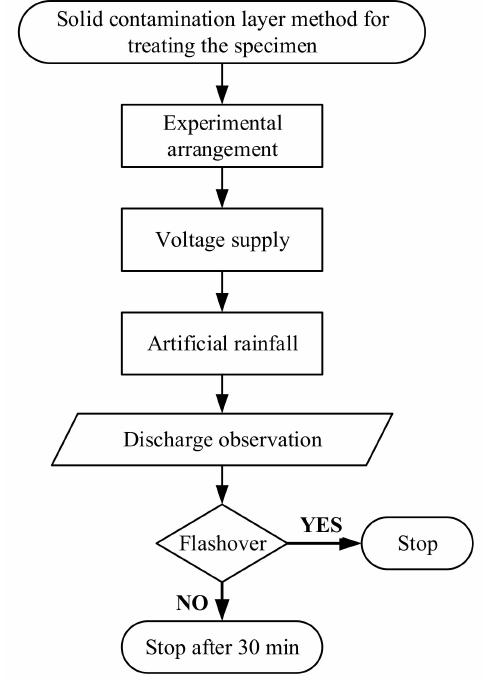
Figure 2. Test flow chart of the artificial contamination rain flashover test.